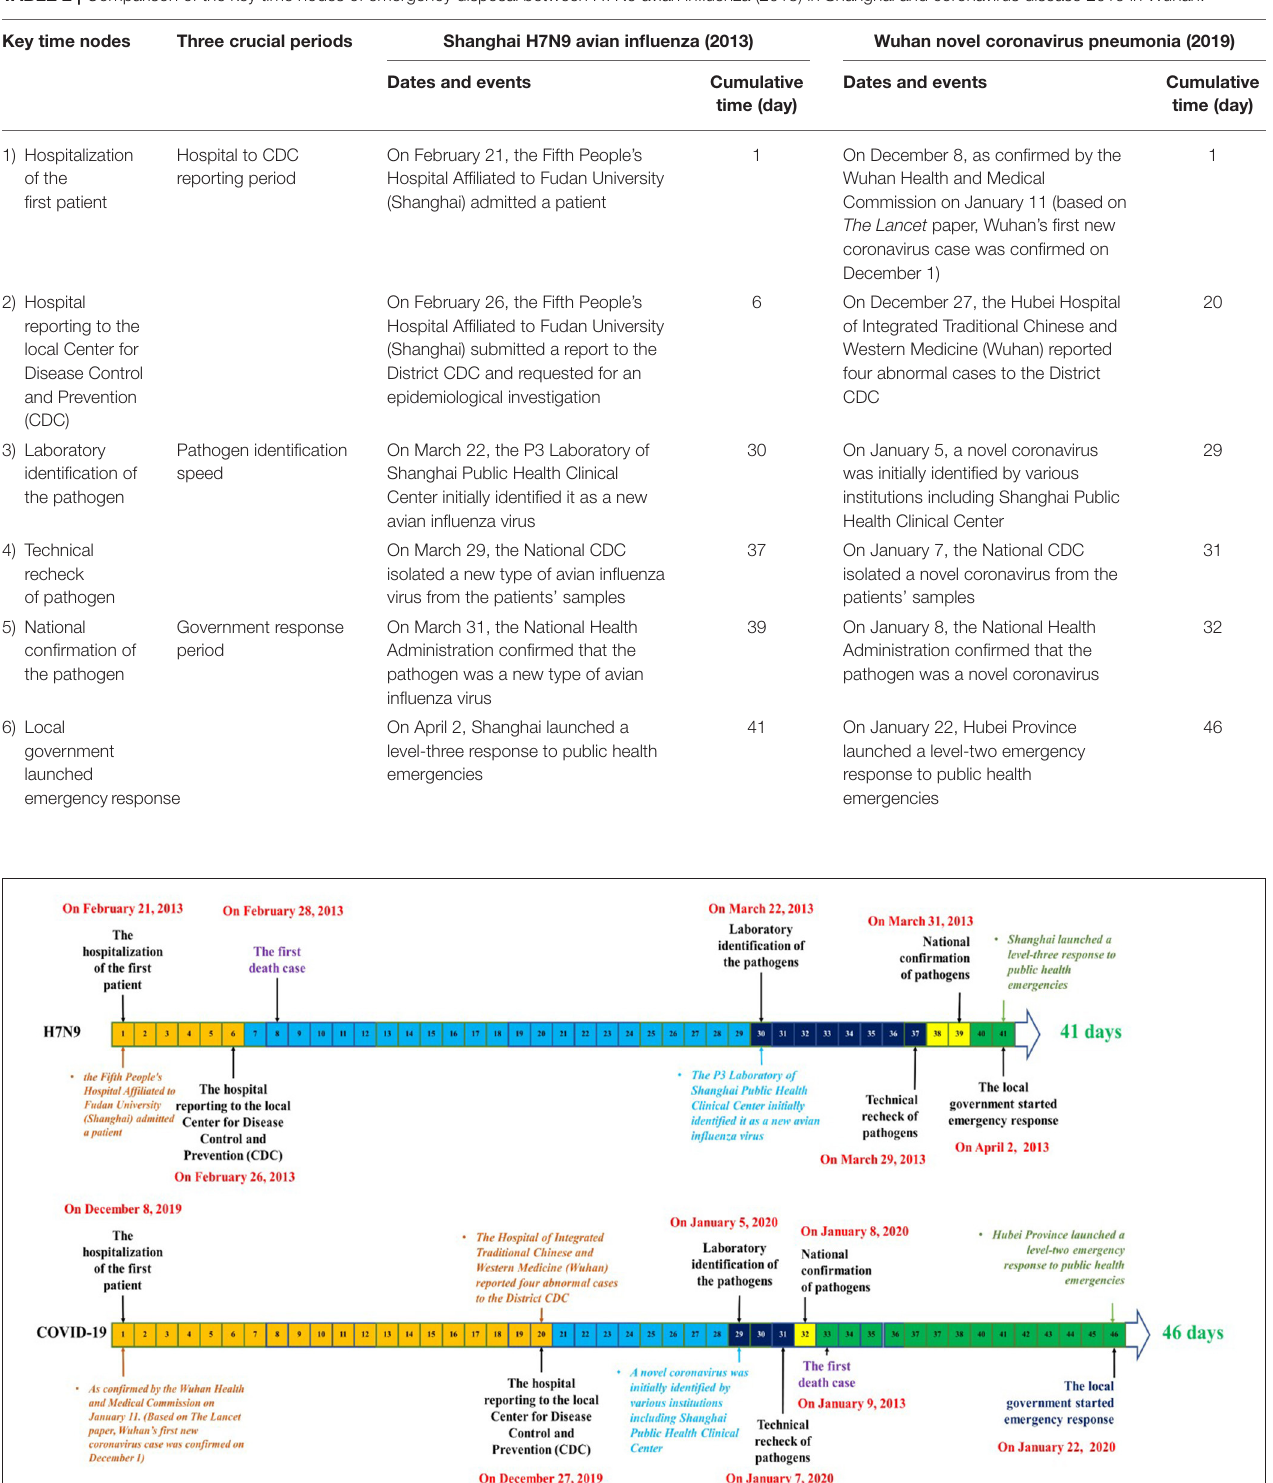
Frontiers in Public Health |